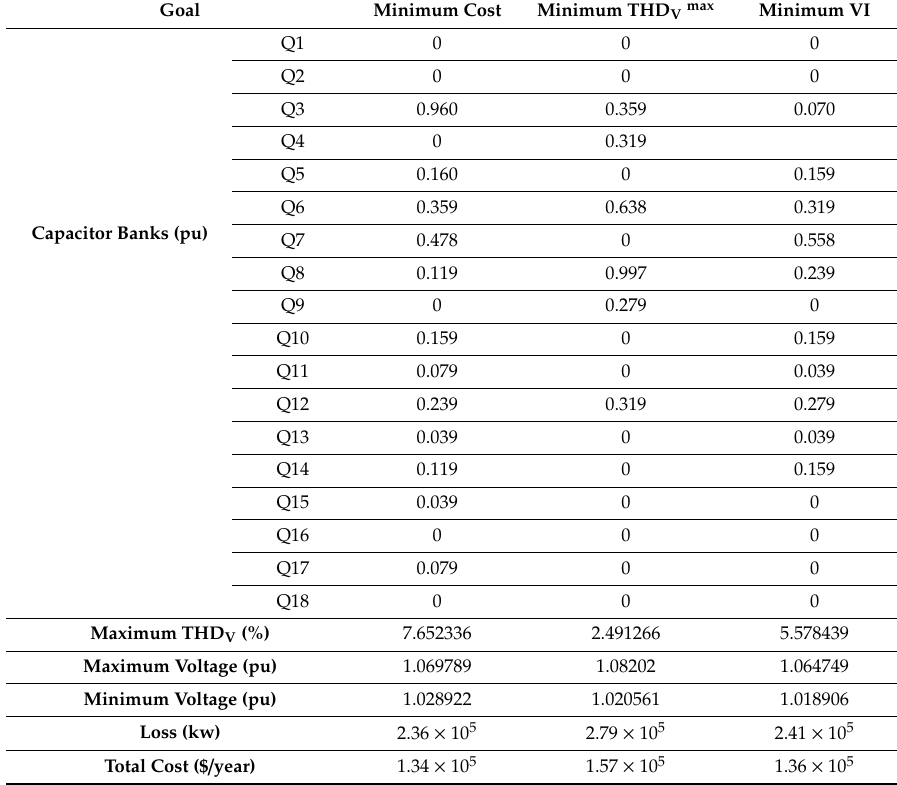
Table 1. Results for the solutions with the lowest cost, the lowest THD, and the most appropriate response.